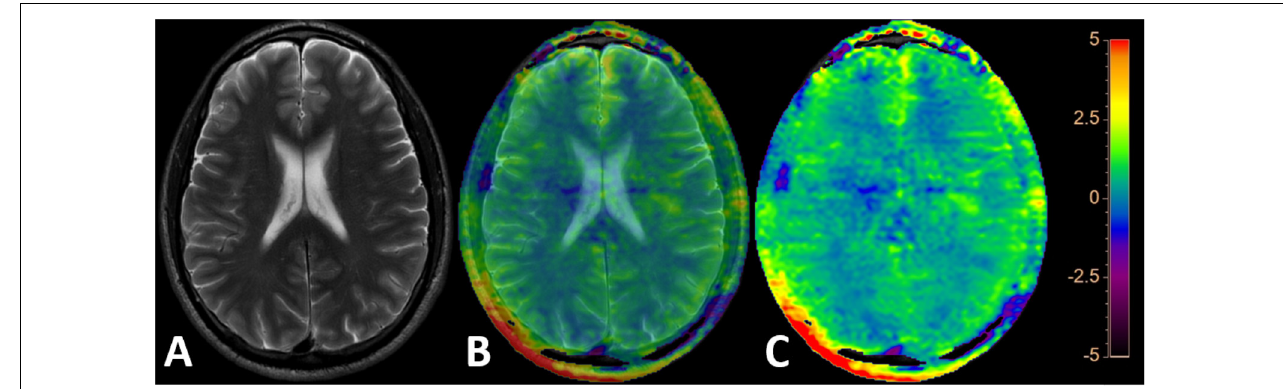
FIGURE 1 | The pure 2D T2w TSE image (A) , a mixed 2D T2w TSE and APTw image (both each 50% contributing as shown in B ) and the pure APTw color coded image (C) are depicted after fusion and coregistration of the 2D T2w TSE and the APTw image. “Rainbow” color coding is used depicting the APTw signal intensity from − 5 to +5%.